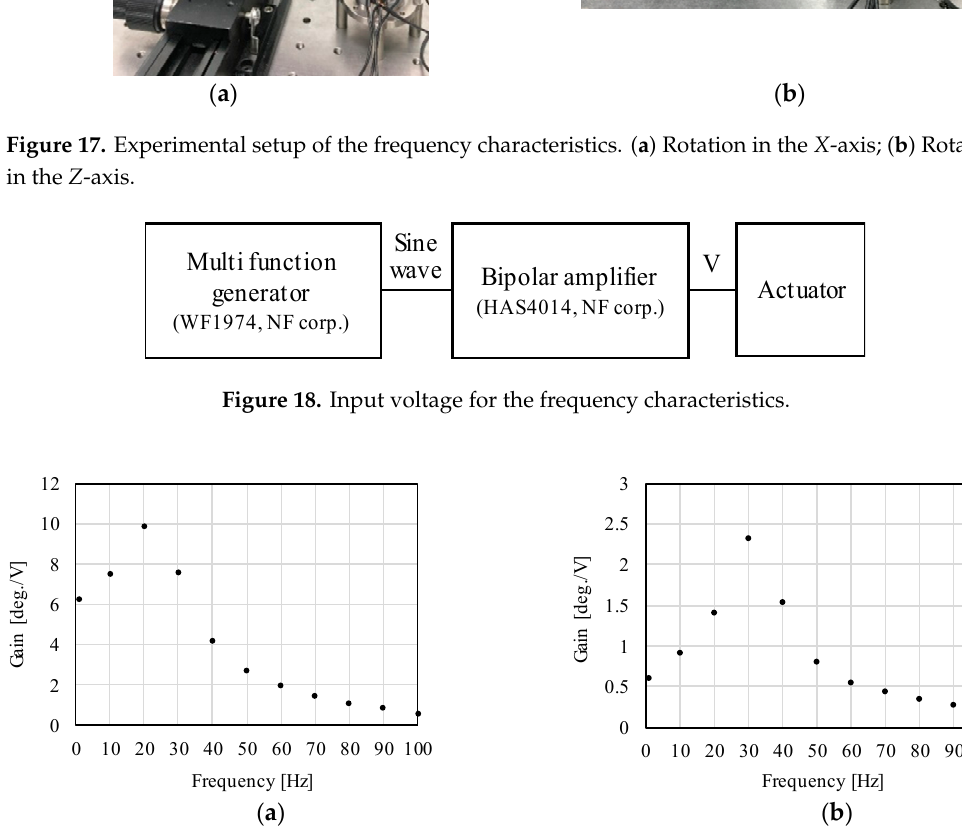
Figure 19. Measured results of the frequency characteristics. ( a ) Rotation in the X -axis; ( b ) Rotation in the Z -axis.